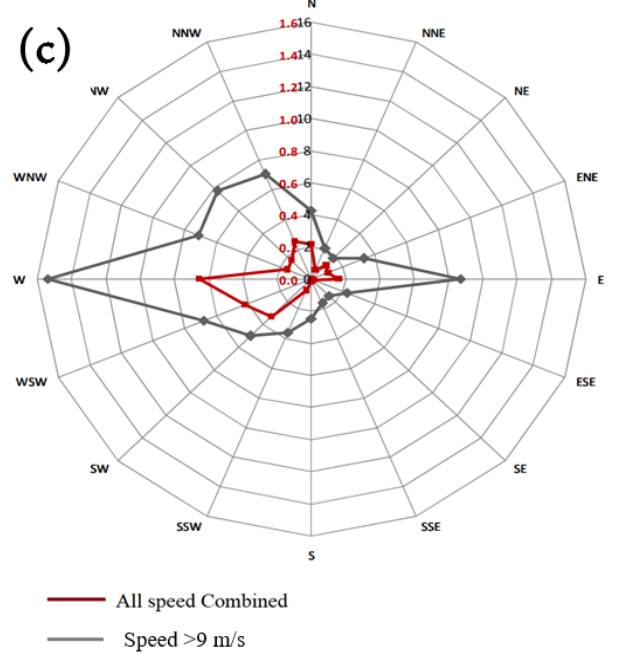
Figure 4. Wave rose ( a ) of the significant wave heights, ( b ) corresponding periods of the significant wave, ( c ) and average annual wind rose.